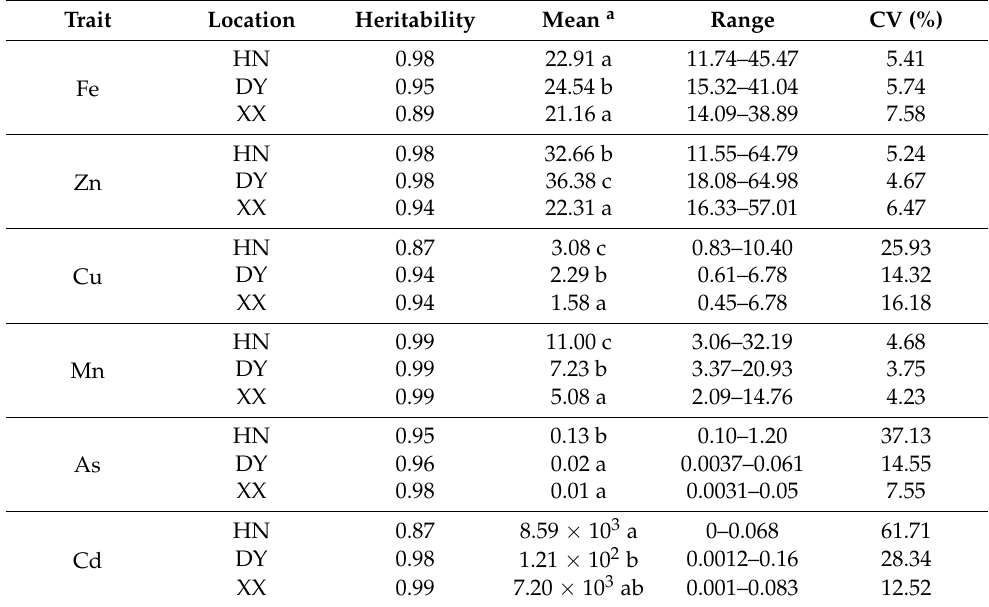
Table 2. Heritability and contents of Fe, Zn, Cu, Mn, As and Cd in maize kernel in three locations.